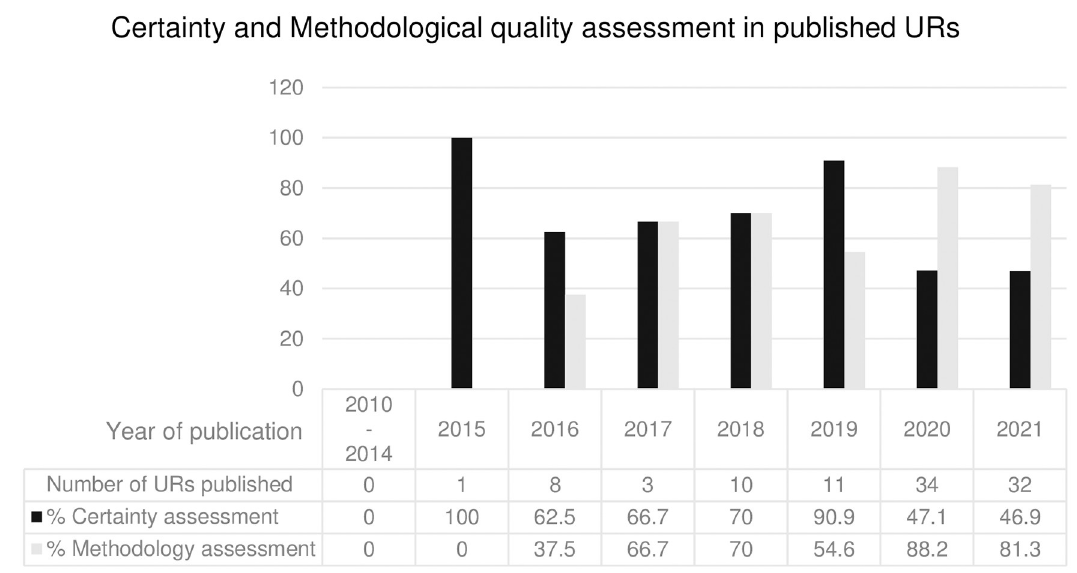
Fig 3. The proportion of studies employing certainty and methodological quality assessment over